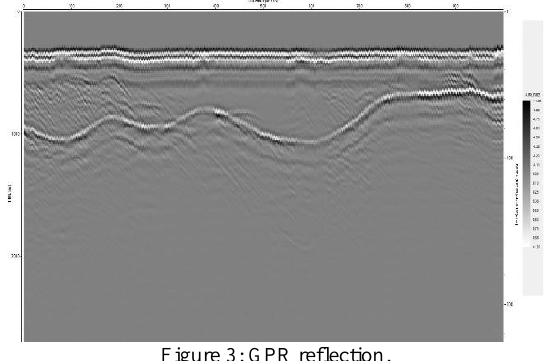
Figure 3: GPR reflection.